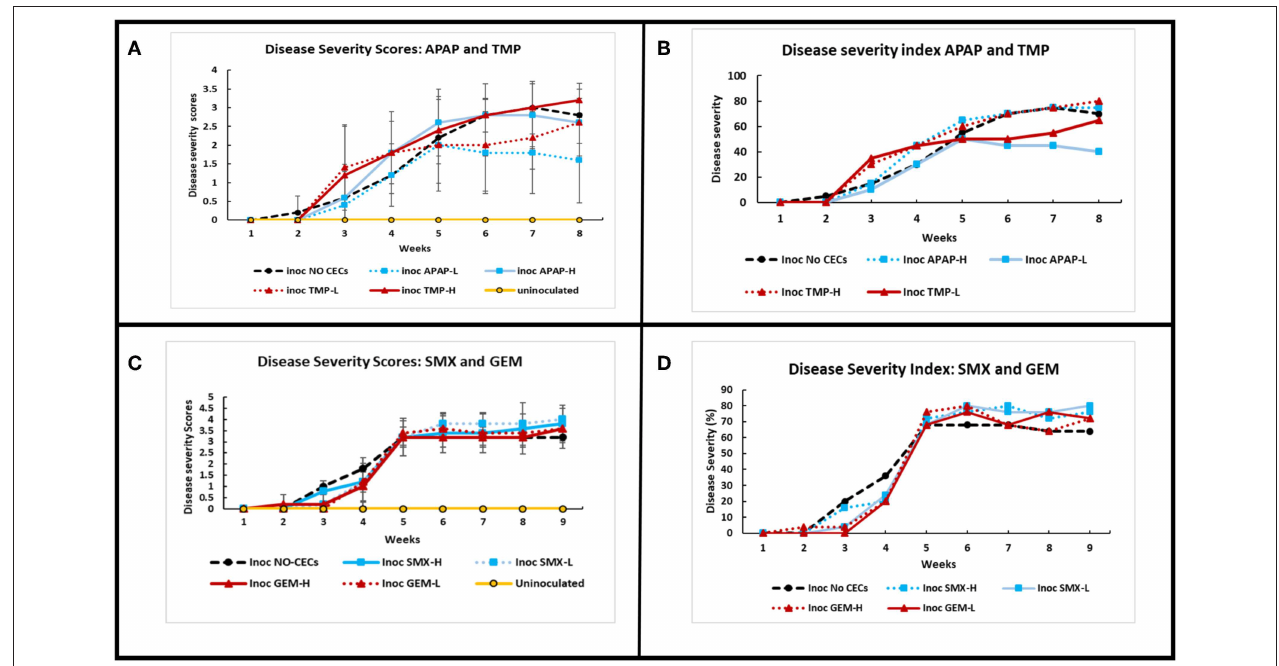
FIGURE 6 | Comparison of disease severity and disease severity index of greenhouse grown eggplants inoculated with Verticillum dahliae and watered with or without the addition of chemicals of emerging concern. Calculations to determine the disease severity index (DSI) are described in Liu et al. (2009b) and Chiang et al. (2017). All error bars shown represent standard deviation. (A) Disease severity of inoculated and uninoculated eggplants for acetaminophen (APAP) and trimethoprim (TMP), treatments. (B) Comparing DSI values for APAP and TMP treatments over time. (C) Disease severity of inoculated and uninoculated eggplants for sulfamethoxazole (SMX) and gemfibrozil (GEM)treatments over time. (D) Comparing DSI values for SMX and GEM treatments over